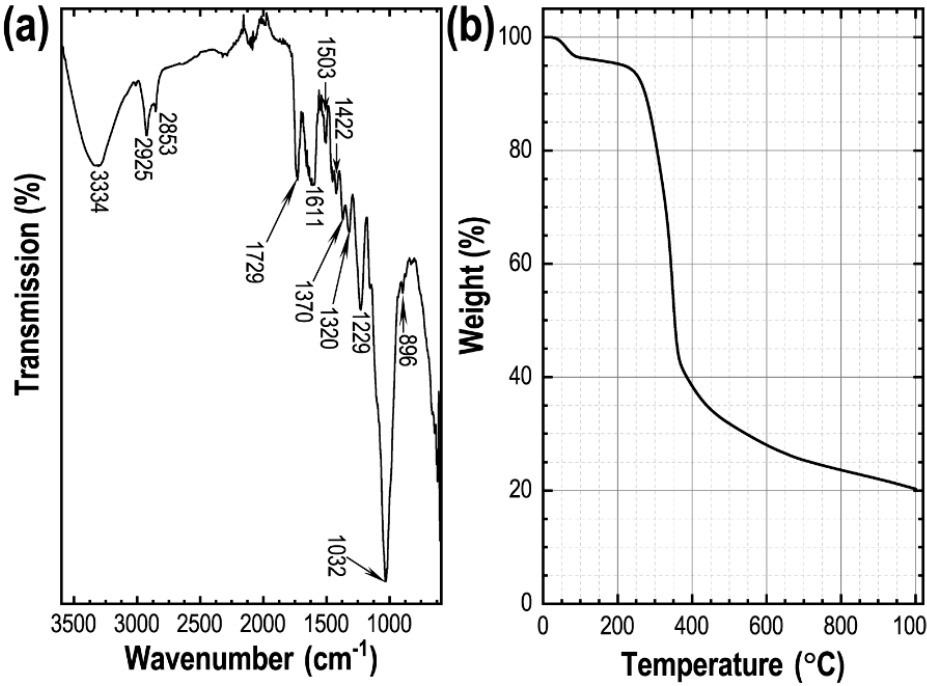
Figure 1. ( a ) FTIR spectrum of the precursor ( Phyllanthus emblica seed powder); ( b ) the corresponding TGA curve.